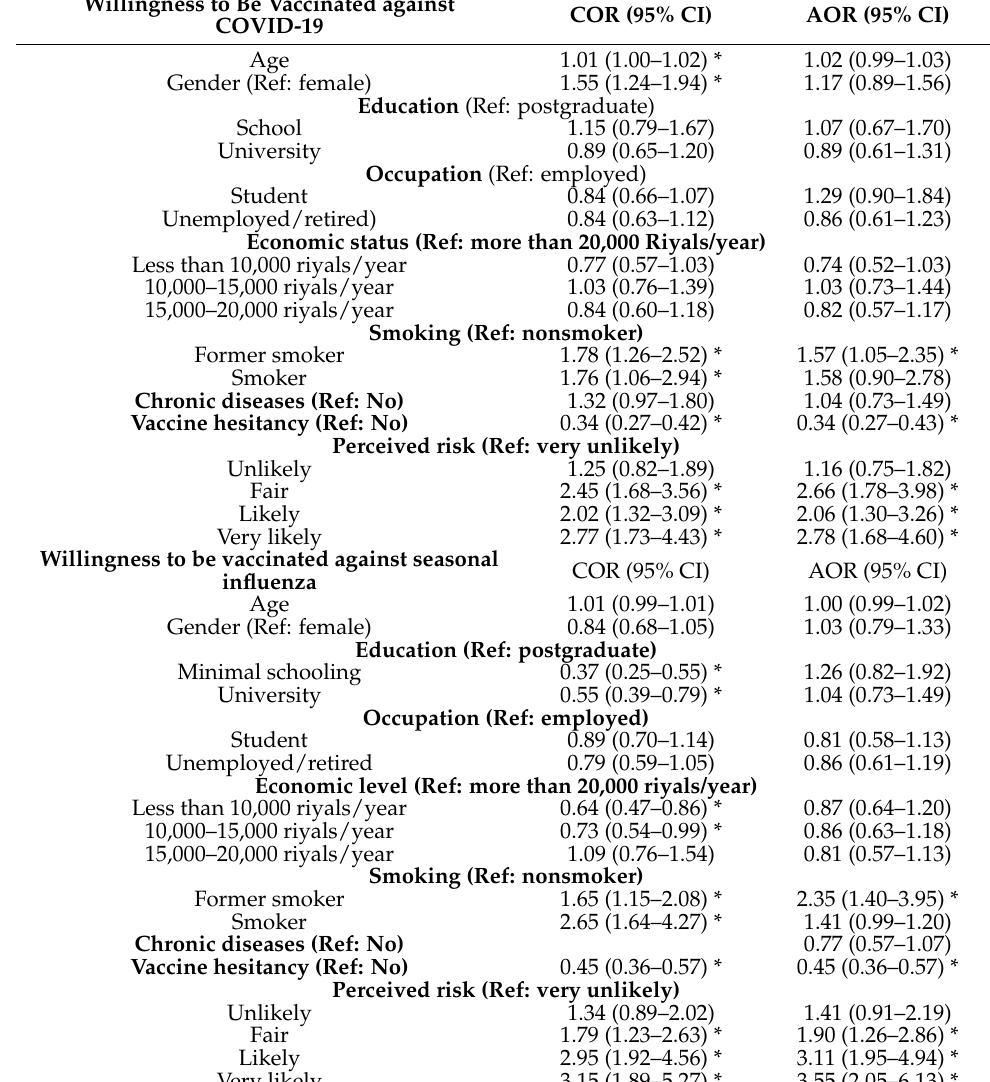
Table 3. Factors associated with willingness to be vaccinated against COVID-19 and seasonal influenza among the study